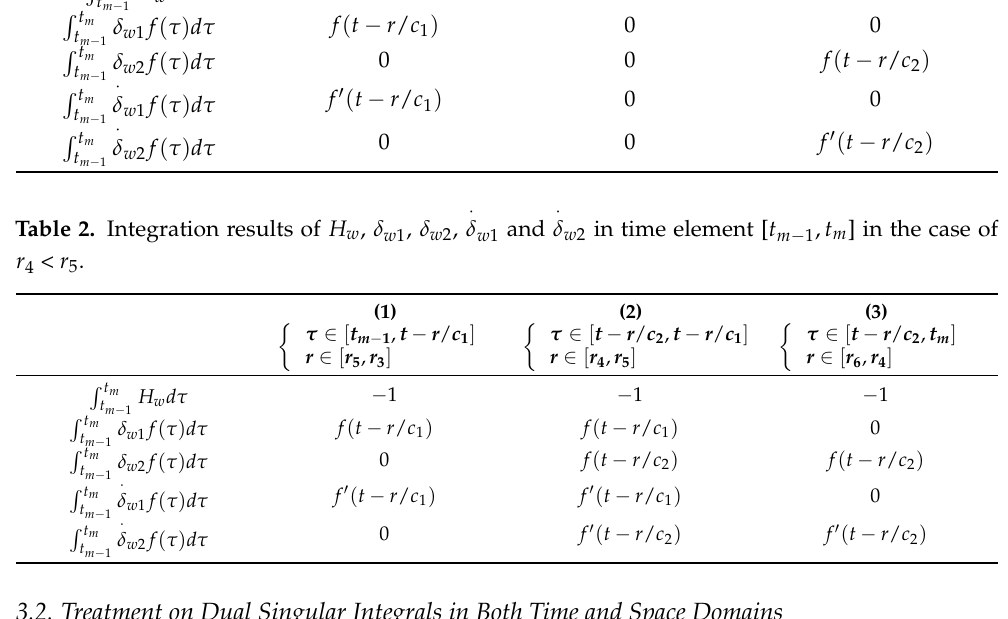
· · δ w 1 and δ w 2 in time element [ t m − 1 , t m ] in the case of